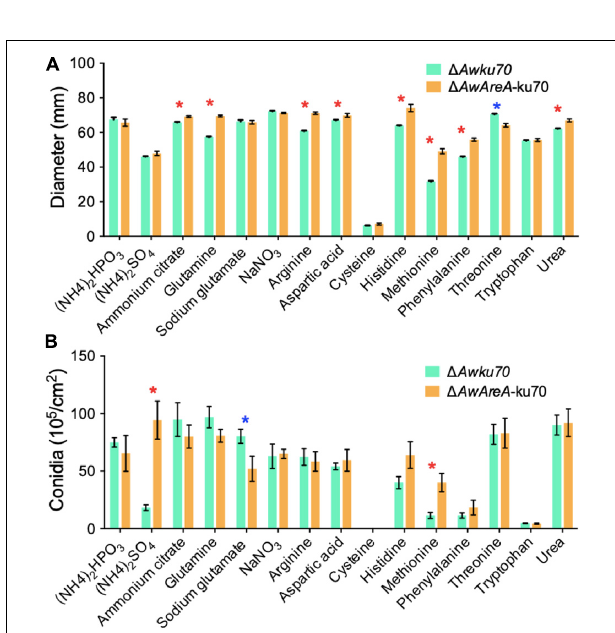
FIGURE 5 | Effect of AwAreA deletion on the colony growth and conidiation of Aspergillus westerdijkiae on different nitrogen sources. (A) Diameter of (cid:49) Awku70 and (cid:49) AwAreA -ku70. (B) The conidia number of (cid:49) Awku70 and (cid:49) AwAreA -ku70. The asterisk in red/blue color indicates a significant increase/decrease between the corresponding values ( p < 0.01) with three biological